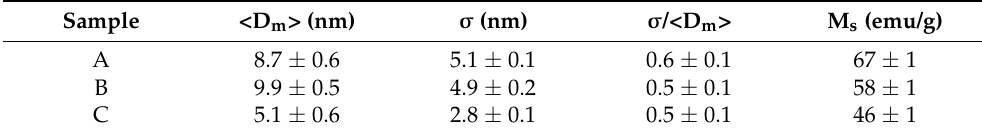
Table 5. Results of the analysis of the magnetization curves for the three samples. <D m > is the average diameter of the magnetic domains, σ the standard deviation of the distribution, σ /<D m > the relative standard deviation. M s is the saturation magnetization obtained by fitting the experimental magnetization curves.